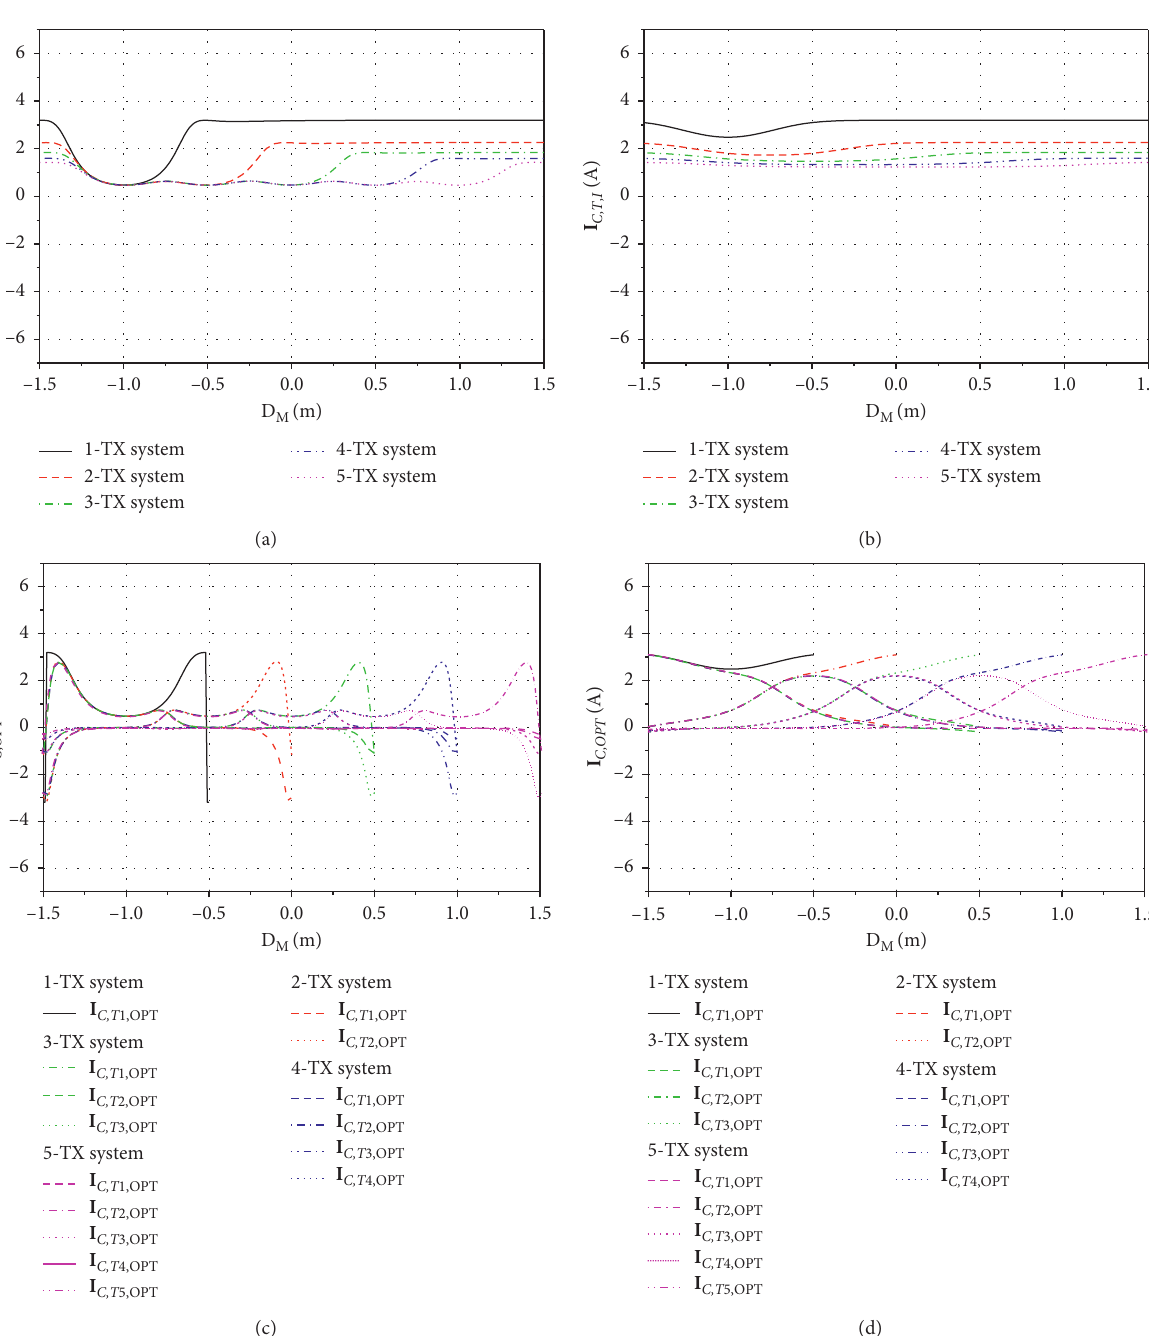
D � 0.3m and (b) D T